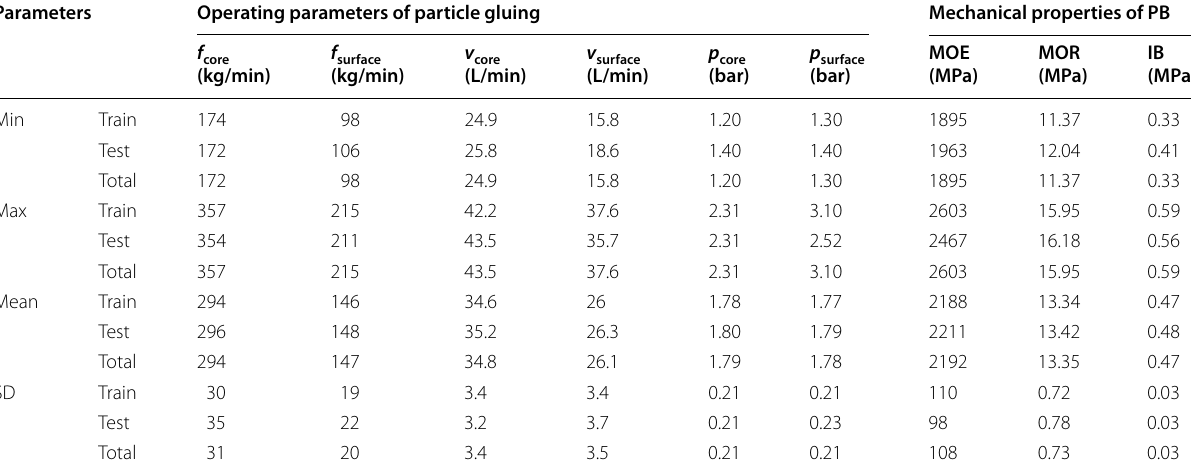
Table 2 The statistical results of mean, Max, Min, and SD of the training set and test set